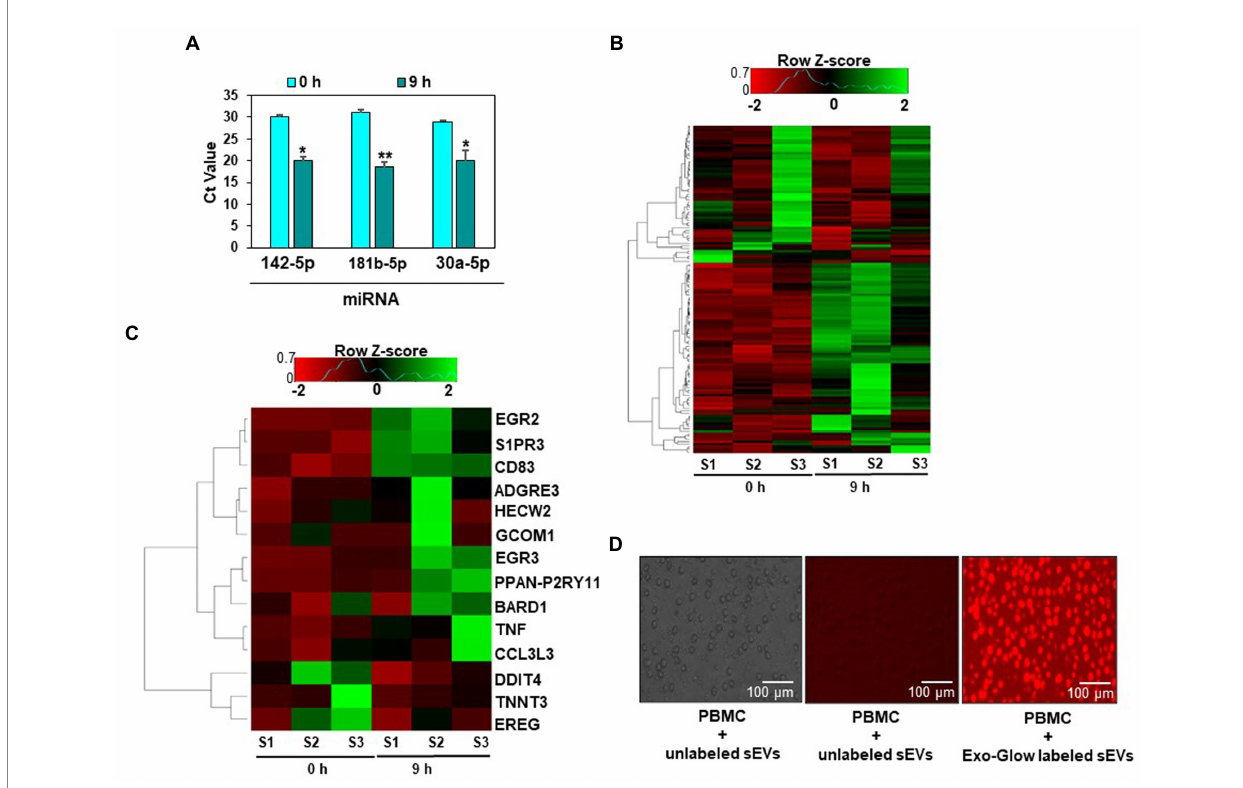
FIGURE 3 Egg small extracellular vesicles (sEVs) deliver miRNAs to human peripheral blood mononuclear cells (PBMCs). Expression of miRNAs detected in PBMCs 9 h after egg consumption. Data are presented as means ± standard deviations. *Value of p <0.05 ( n = 5) for Student’s paired t -test (A) . Heat map of the expression data of all genes in PBMCs (B) . Heat map of fourteen genes for which the expression was at least 2-fold or more different after the egg meal. For each time point, samples ( n = 3) were collected from the same subjects before and after the egg meal (C) . Uptake of Exo-Glow labeled RNAs, encapsulated in egg sEVs by human PBMCs (D)